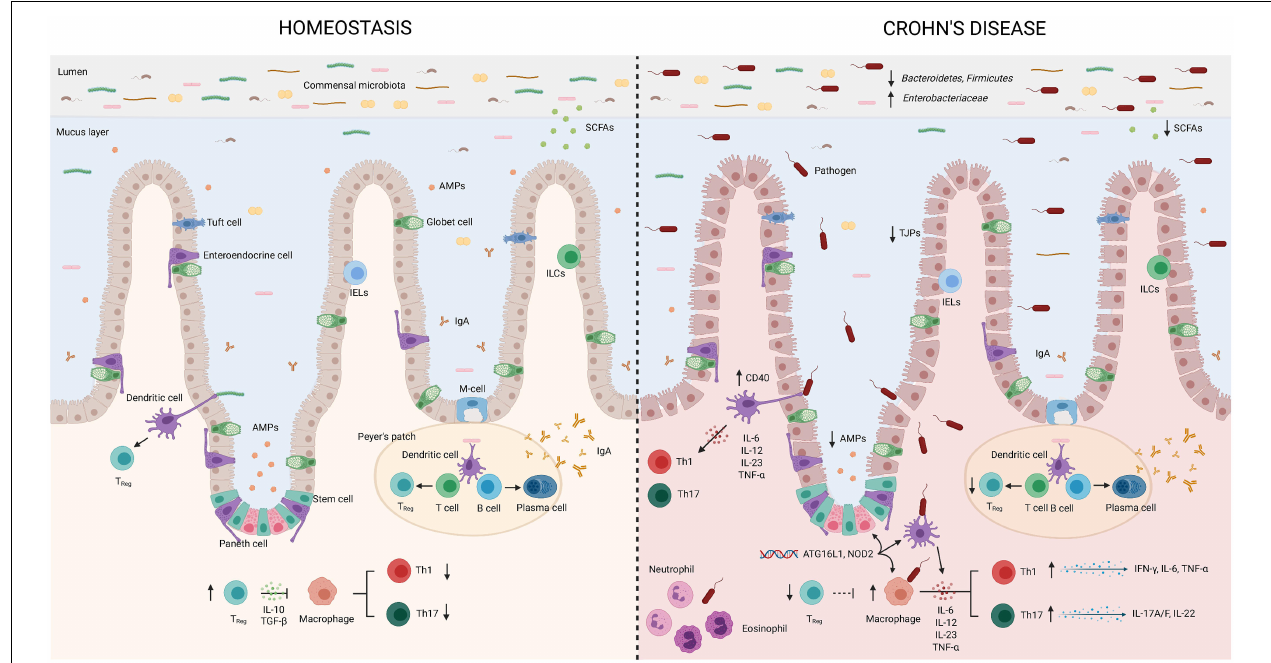
FIGURE 1 | Bacterial translocation in Crohn’s disease. Intestinal tolerogenic mechanisms are altered in Crohn’s disease leading to sustained inflammatory status. Integrity of the epithelial barrier is altered due to reduced expression of tight junction proteins. Increased populations of Enterobacteriaceae and pathogens, as well as reduced Bacteroidetes , Firmicutes , and populations of bacteria producing short chain fatty acids define intestinal dysbiosis in CD. Paneth cells display alterations in the production and secretion of antimicrobial peptides that can be explained by the gene status (NOD2). Translocating bacteria or its products can activate antigen presenting cells as macrophages and dendritic cells. Gene variants in ATG16L1 and NOD2 are associated with abnormalities in the secretion of antimicrobial peptides by Paneth cells and altered function of intestinal DCs and macrophages. Dendritic cells express higher levels of CD40 leading to increased interactions with T-lymphocytes and production of proinflammatory cytokines. Low regulatory T-lymphocyte differentiation will favor Th1 and Th17 subsets that will further produce proinflammatory cytokines. Neutrophils and eosinophils will be recruited to the site of infection and further contribute to induce an inflammatory environment in the attempt to eliminate translocating bacteria. AMPs, antimicrobial peptides; IgA, Immunoglobulin A; IL, interleukin; TGF, transforming growth factor; TNF, tumor necrosis factor; IELs, intraepithelial lymphocytes; ILCs, innate lymphoid cells; SCFAs, short chain fatty acids; TJPs, tight-junction proteins; T REG , regulatory T-cells. This figure has been created using the BioRender